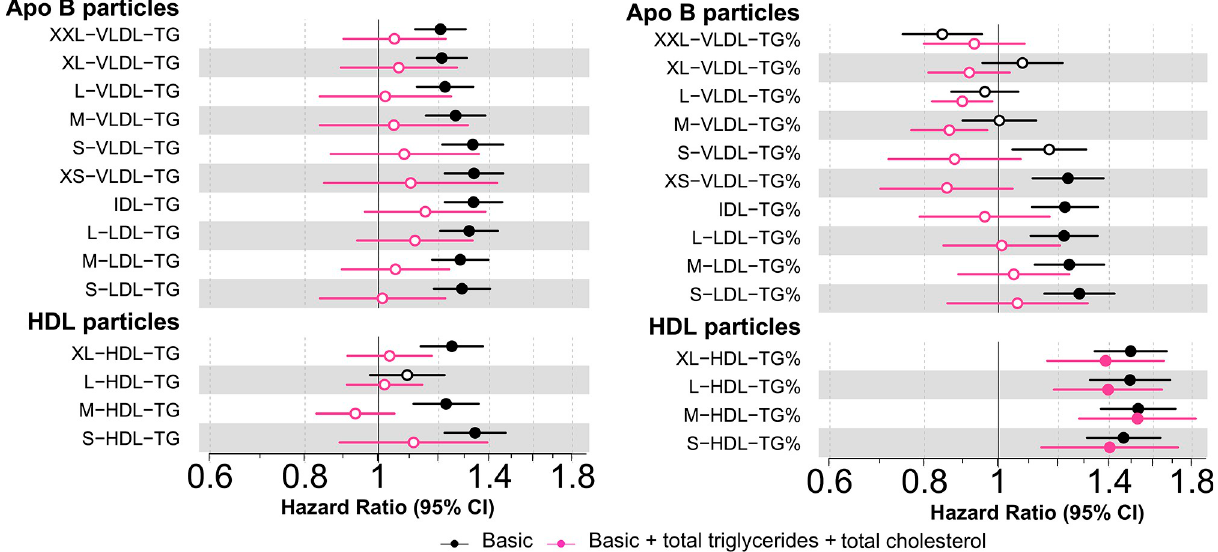
Fig 5. Observational associations of circulating triglyceride concentrations and triglyceride composition in lipoprotein subclass particles and risk of incident CHD. (Left panel) Black: Hazard ratios for incident CHD per SD higher triglyceride concentration within each size-specific lipoprotein subclass adjusted for traditional risk factors. Pink: adjusted for traditional risk factors, serum cholesterol, and serum triglycerides. (Right panel) Black: Hazard ratios for incident CHD per SD higher percentage of triglycerides (of all lipid molecules) within each size-specific lipoprotein subclass adjusted for traditional risk factors. Pink: adjusted for traditional risk factors, serum cholesterol, and serum triglycerides. Basic risk factors include age, sex, mean arterial pressure, smoking, diabetes mellitus, lipid medication, geographical region in FINRISK, and ethnicity in SABRE. The horizontal bars to the 95% CIs. Closed circles represent statistical significance of associations at P < 0.002 and open circles associations that are nonsignificant at this threshold. The horizontal bars refer to the 95% CIs. Underlying data can be found in S1 Data. Apo B, apolipoprotein B; CHD, coronary heart disease; HDL, high- density lipoprotein; IDL, intermediate-density lipoprotein; LDL, low-density lipoprotein; VLDL, very-low-density lipoprotein; TG, triglycerides.